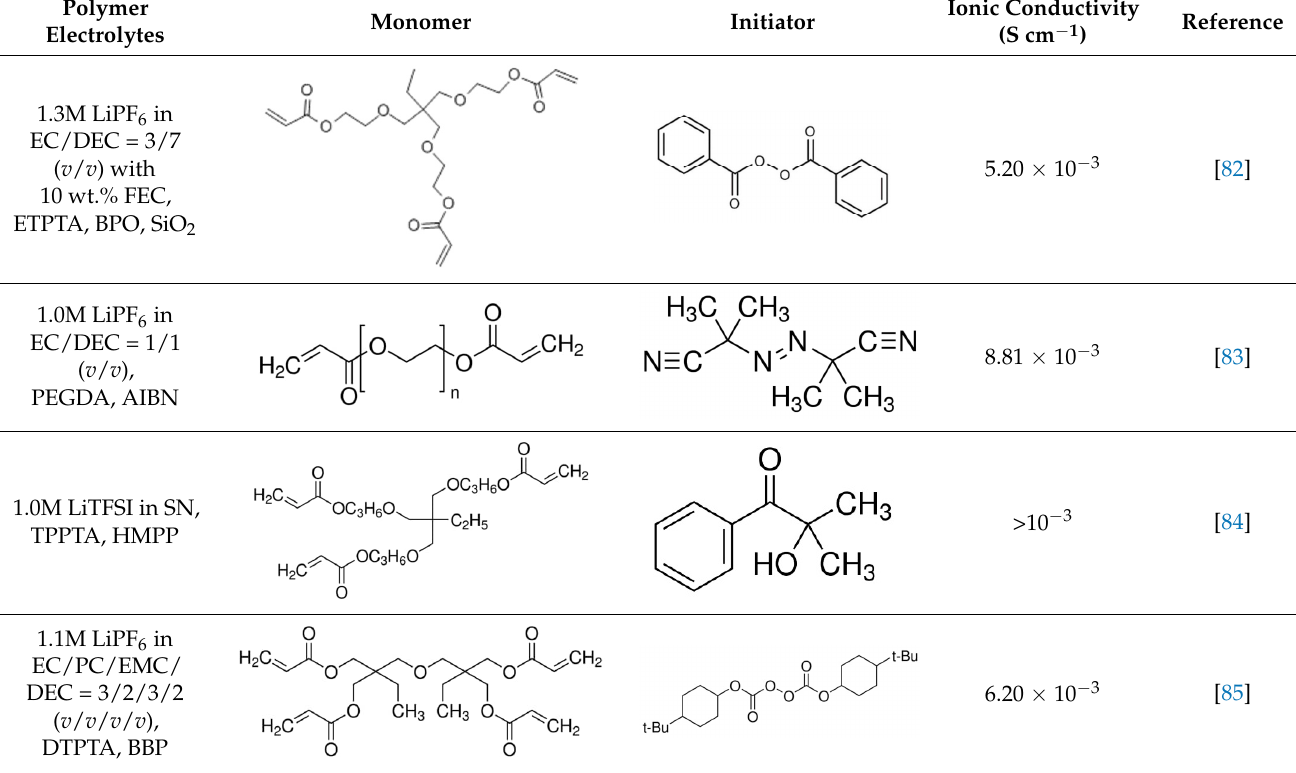
Table 4. Monomers, initiators, and ionic conductivity values of PEs.